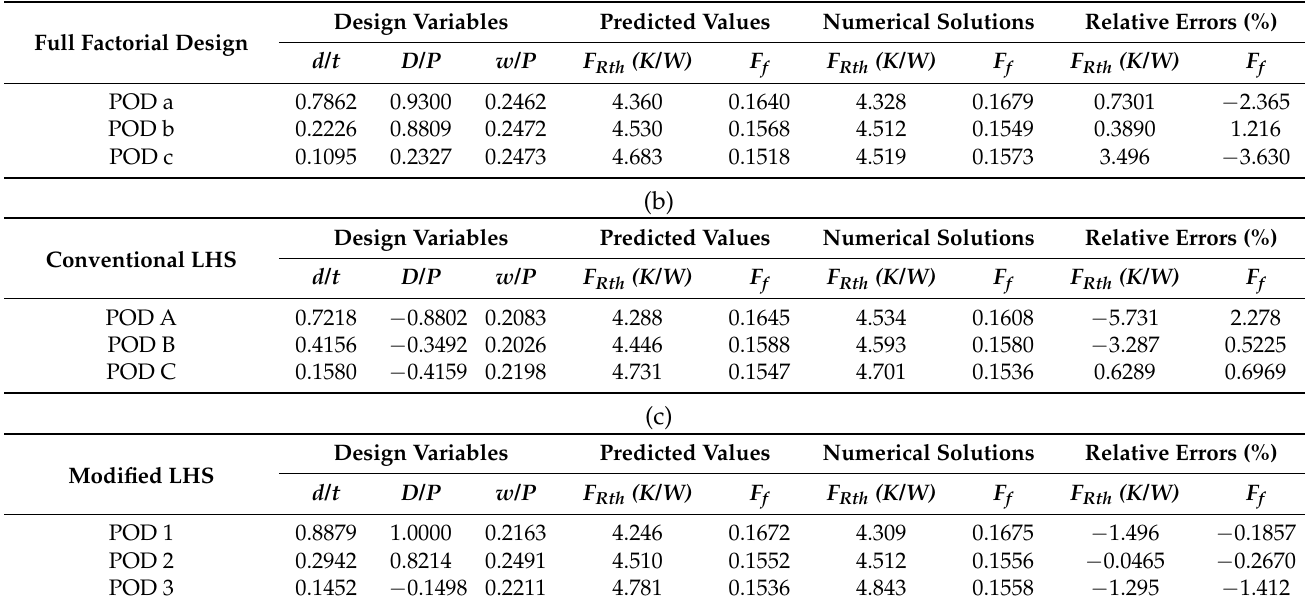
Table 5. Results of optimizations with three different DOEs. (a) Full factorial design; (b) Conventional LHS; (c) Modified LHS.